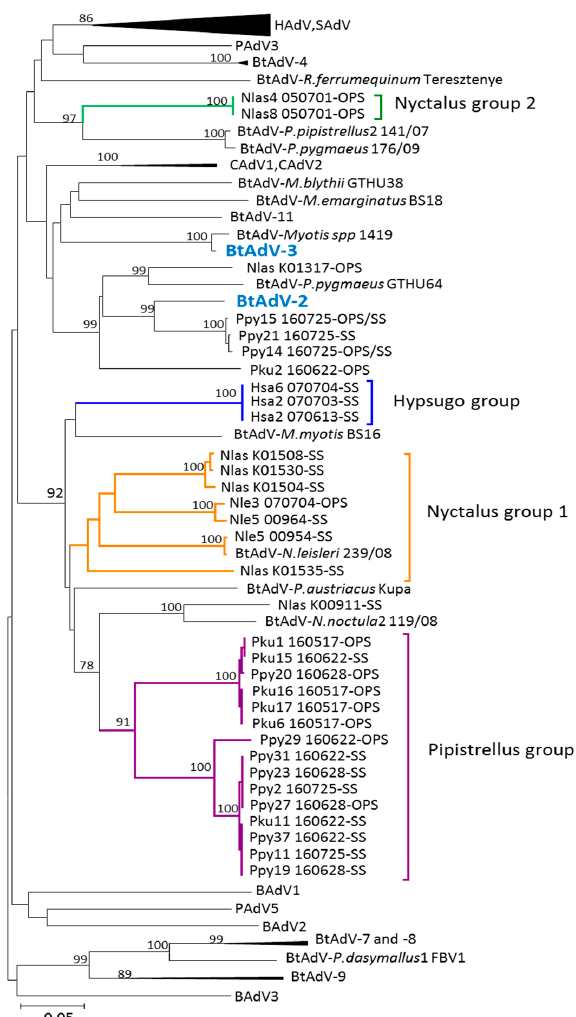
Figure 3. Phylogenetic tree based on the analysis of the DNA-dependent DNA polymerase partial gene. Trees were estimated with MEGA 5.2 software by using the neighbour-joining method on Kimura 2 parameters model. A bootstrap test was replicated for 5000 times. Numbers represent percentage bootstrap support. GenBank accession numbers for the sequences included in the tree are as follows: BtAdV-3 (strain TJM, GU226970, Bat mastadenovirus A ), BtAdV-2 (strain PPV1, JN252129, Bat mastadenovirus B ), human AdVs: type 1 (AF534906), type 2 (J01917), type 3 (DQ086466), type